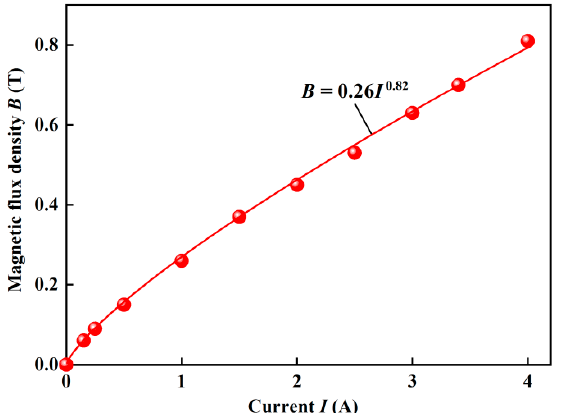
Figure 1. The magnetic flux density versus the applied current.